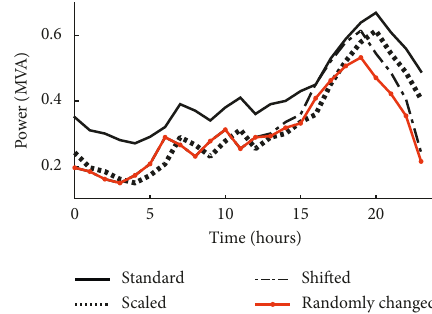
Figure 15: Modified load shapes (the standard load shape is residential weekday load shape).